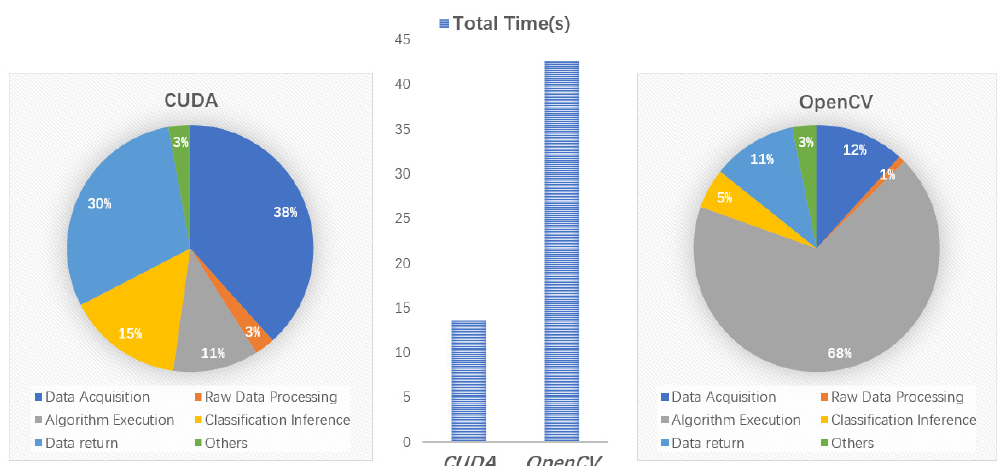
Figure 12. The total time and the proportion of several predominant operations of CUDA and OpenCV version in one shutter process.